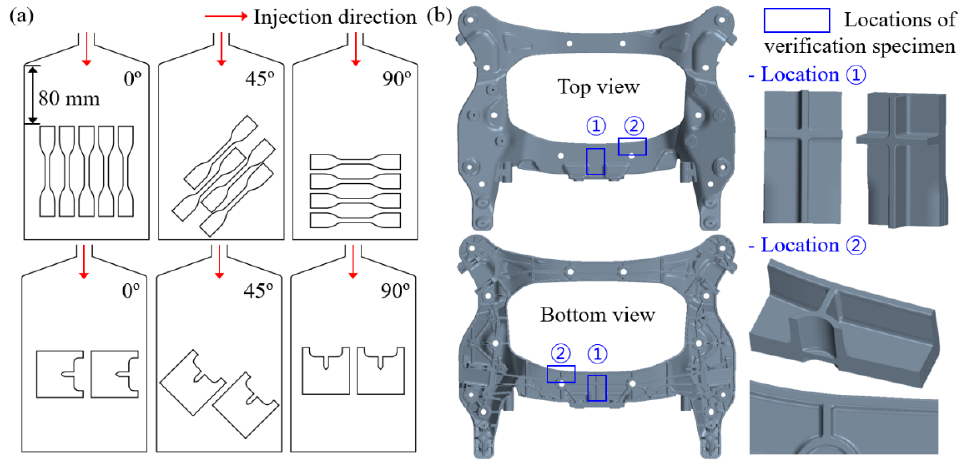
Figure 3. ( a ) Direction and location of specimens cut from injection molded plates. ( b ) Locations and geometries of verification specimens in injection-molded automobile cross-member components.